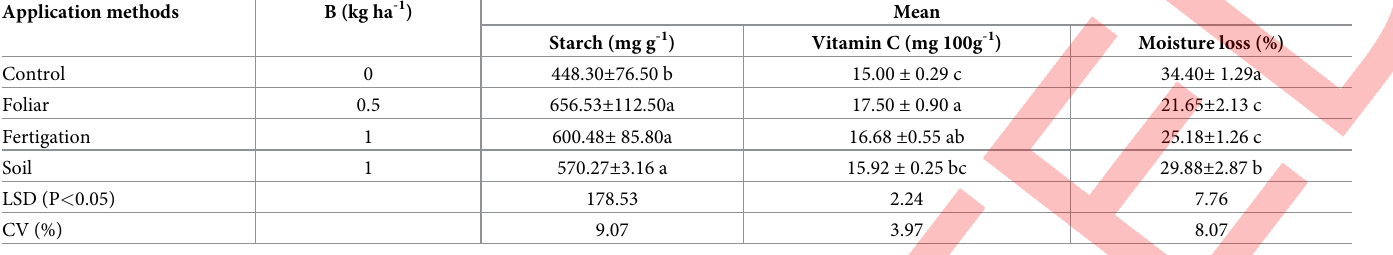
Table 3. Effects of boron application methods on starch and vitamin C contents and boron use efficiency of potato crop. Application methods